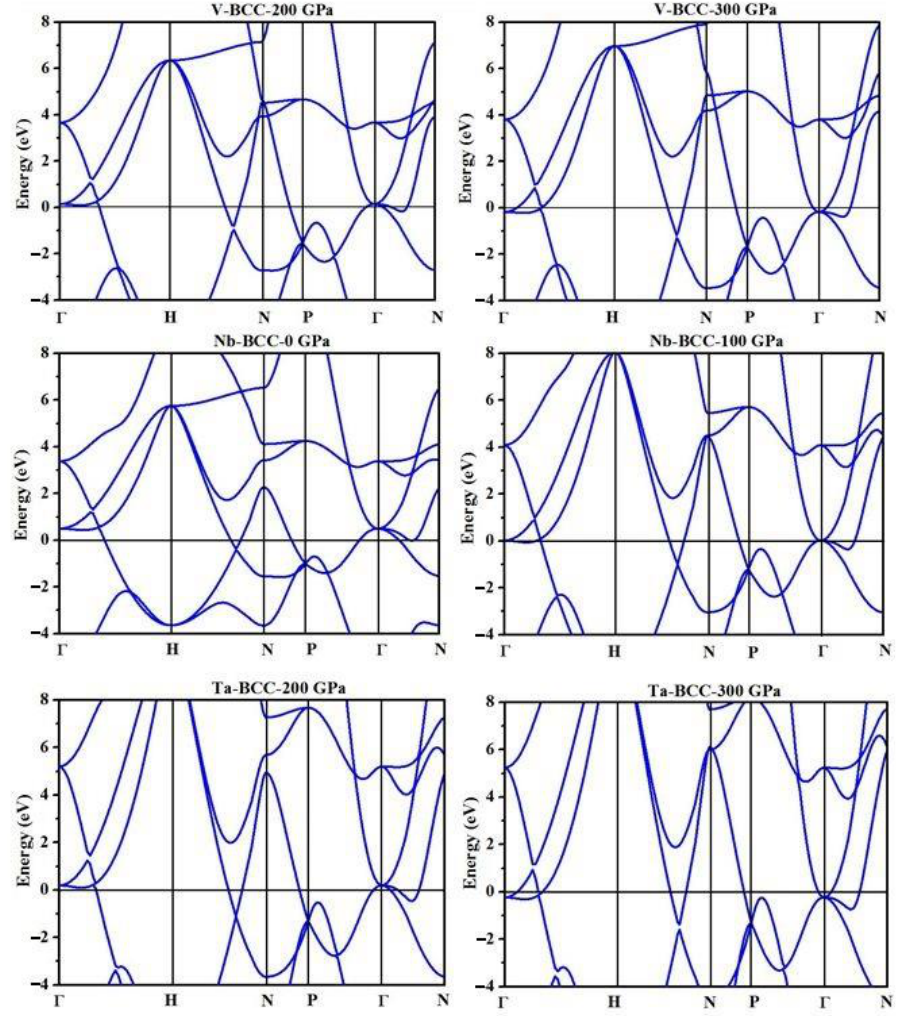
Figure 9. Band structures of vanadium, niobium, and tantalum in BCC phase at various pressures. (By the courtesy of Ref. [56]).